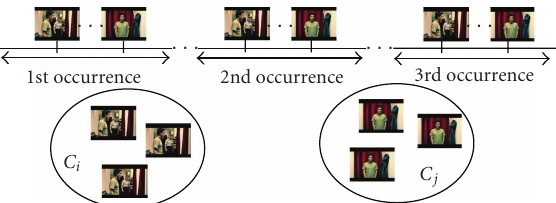
Figure 6: Generation of a three times repeated sequence from two